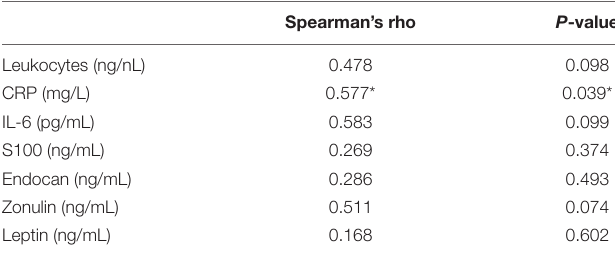
TABLE 4 | Correlation of DC shifts at LOC ( µ V) and laboratory